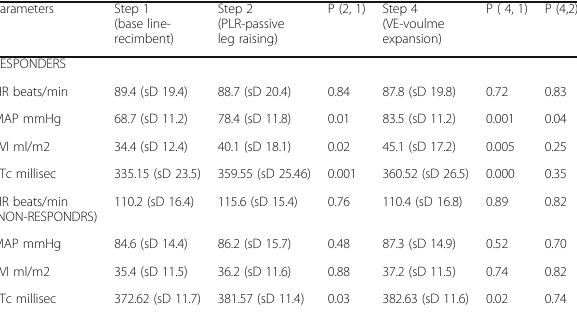
Table 12 (abstract A11). Hemodynamics post PLR and Volume Expansion (VE) Parameters